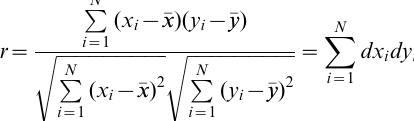
ffiffiffiffiffiffiffiffiffiffiffiffiffiffiffiffiffiffiffiffiffiffiffiffi P N